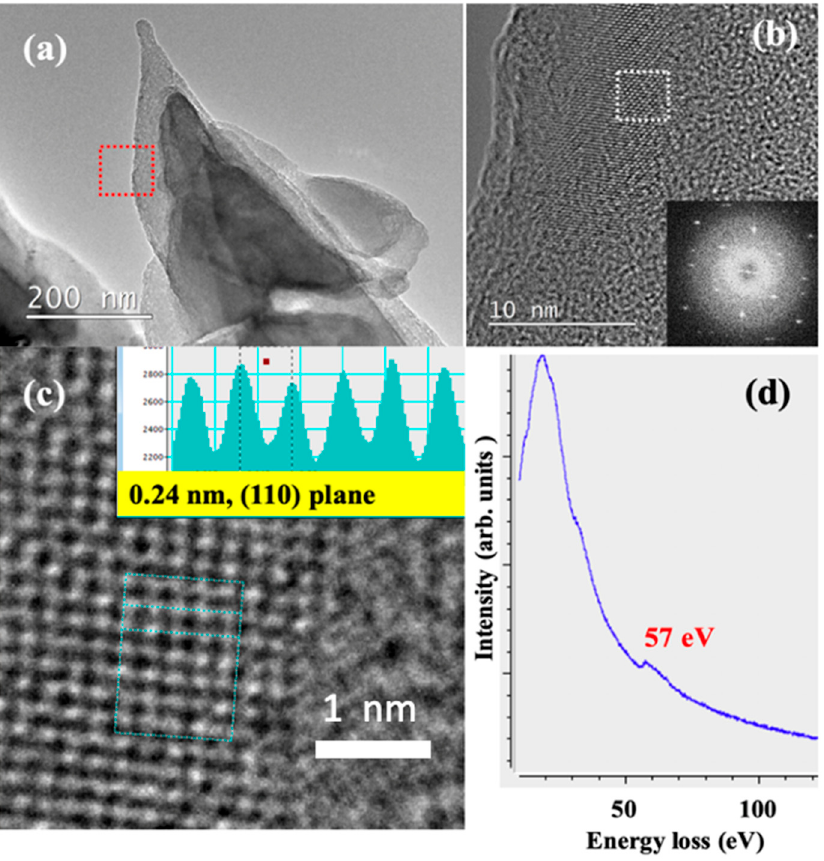
Figure 2. ( a ) TEM image of a typical Li-C NC. ( b ) High mag TEM image of the squared area of Figure 2a (the inset shows the fast Fourier transform (FFT) pattern of the area indicated by the white square). ( c ) High mag TEM of the squared area of Figure 2b showing Li lattice embedded in the C matrix. ( d ) Energy loss spectroscopy (EELS) spectra showing the presence of Li at 57 eV.